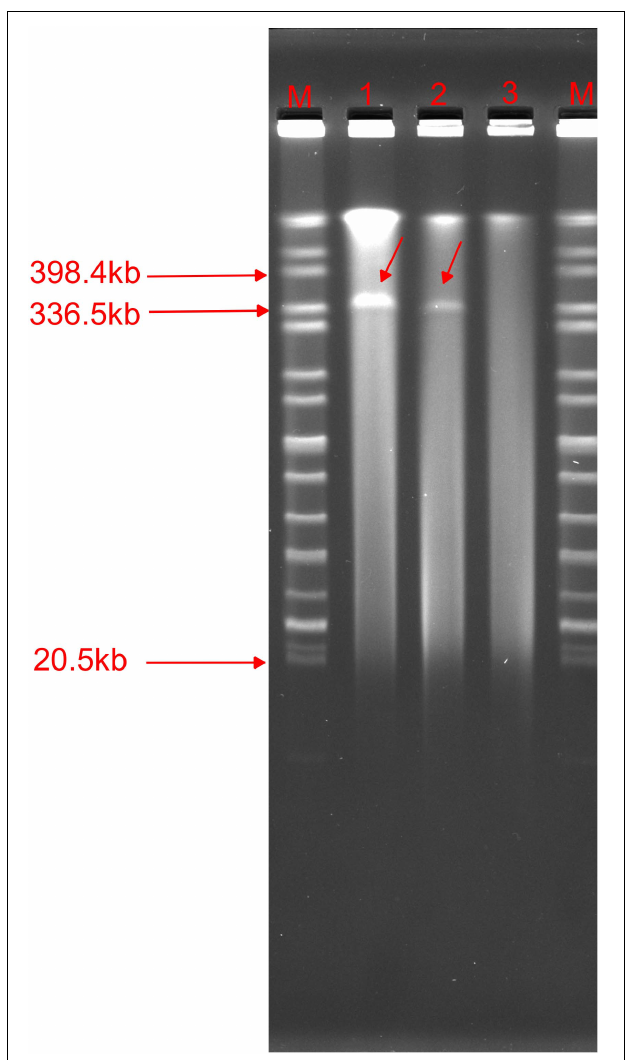
FIGURE 4 | S1-nuclease pulsed-field gel electrophoresis profiles. M, Salmonella enterica serotype Braenderup strain H9812; 1,1575; 2, p1575-1-EC600; 3,